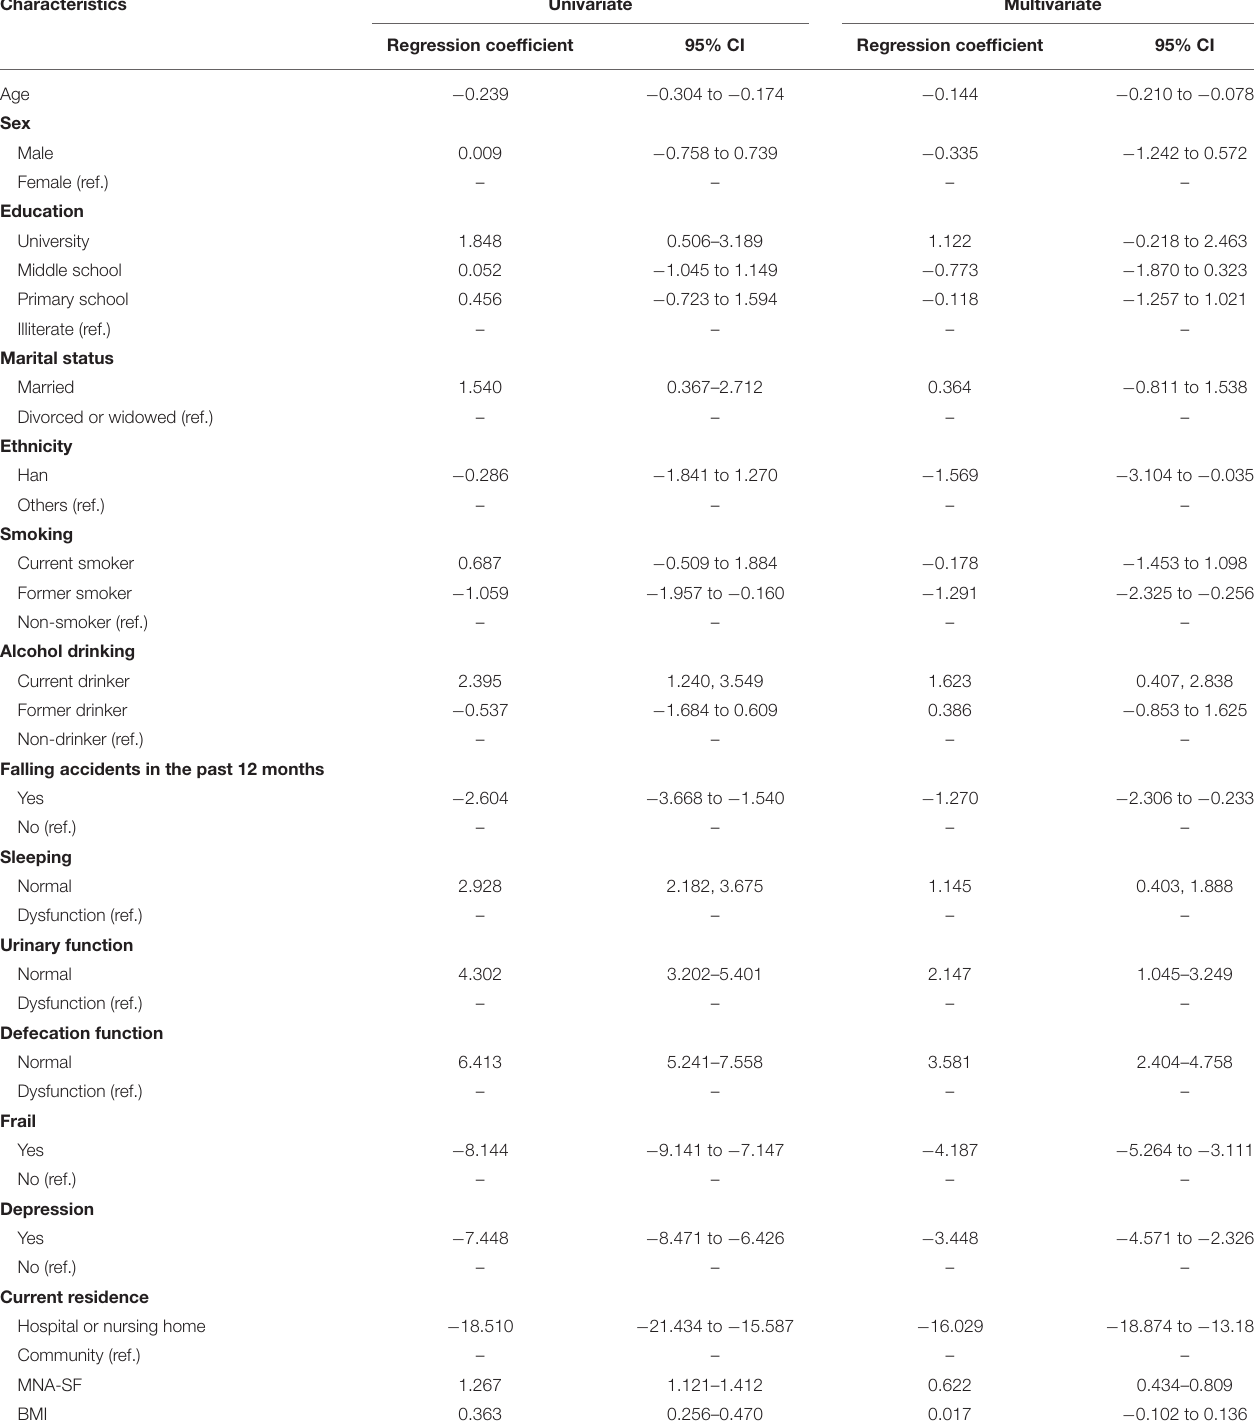
TABLE 5 | Variables that can affect the EQ5DVAS score from the regression model (90-day follow-up).